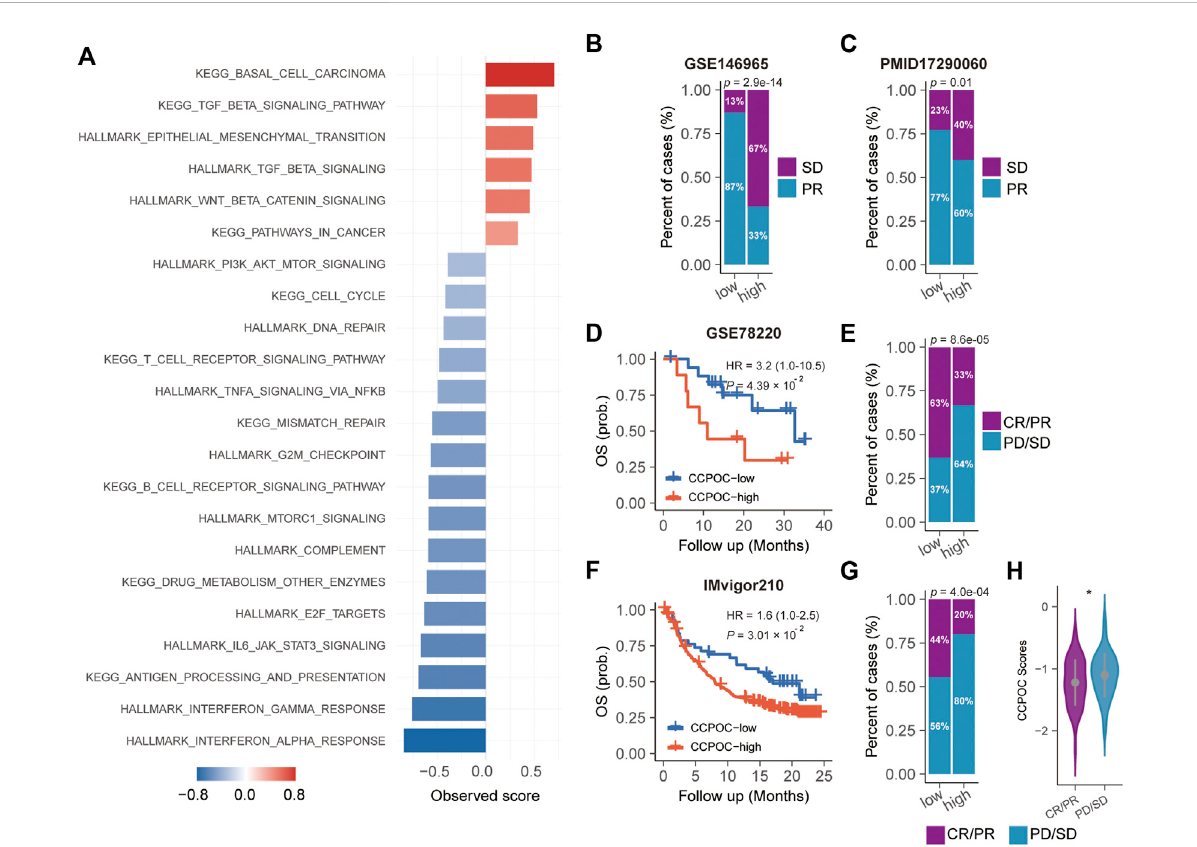
FIGURE 6 Dysregulated pathways and drug sensitivity within the CCPOC groups. (A) Enrichment of dysregulated pathways between the high- and low- CCPOC groups. (B) and (C) chemotherapy sensitivity analysis. Survival analyses for the CCPOC groups in the GSE78220 cohort (D) and the IMvigor210cohort (F) .Proportionofpatientswithresponsetoanti-PD-1/L1immunotherapyinlow-orhigh-CCPOCgroupsintheGSE78220cohort (E) and the IMvigor210 cohort (G) . (H) Distribution of the CCPOC scores in CCPOC groups. CR, complete response; PR, partial response; SD, stable disease; PD, progressive